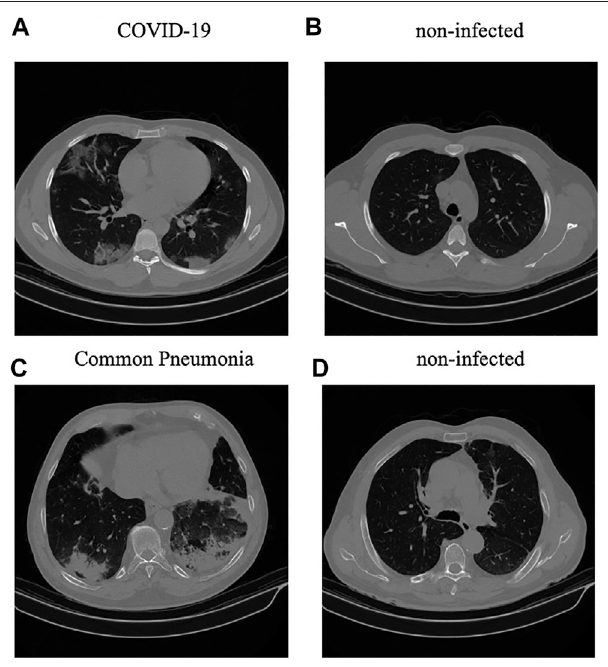
FIGURE 1 | ( A , B) : Infected and non-infected sample slices in a COVID- 19 case; (C , D) : Infected and non-infected sample slices in a non-COVID Pneumonia